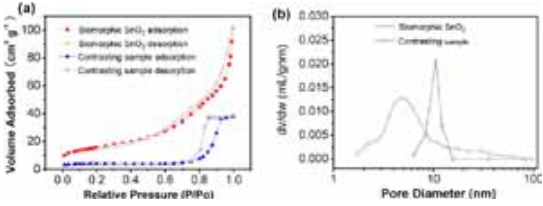
Fig. 13 TEM images of (a) part of single SnO (b) the top view of the ridge, (c) the cross sec- tion of the ridge, (d) the tip of the tube, (e) SnO nanoparticles building blocks, inset 2 showing the SAED patterns; (f) the HRTEM image of the rectangular region in (e).